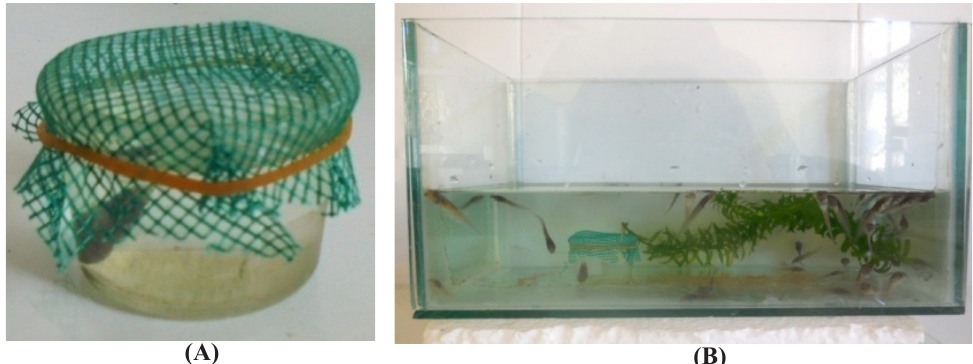
Figure 3: Experimental set up to expose tadpoles to cercariae. A) shows a freshwater snail shedding cercariea is placed inside a plastic cup covered with a mesh and B) shows the cup with the snail is being placed inside a glass tank containing twenty tadpoles of Polypedates cruciger at 10 days post-hatch (Gosner stage 27 /